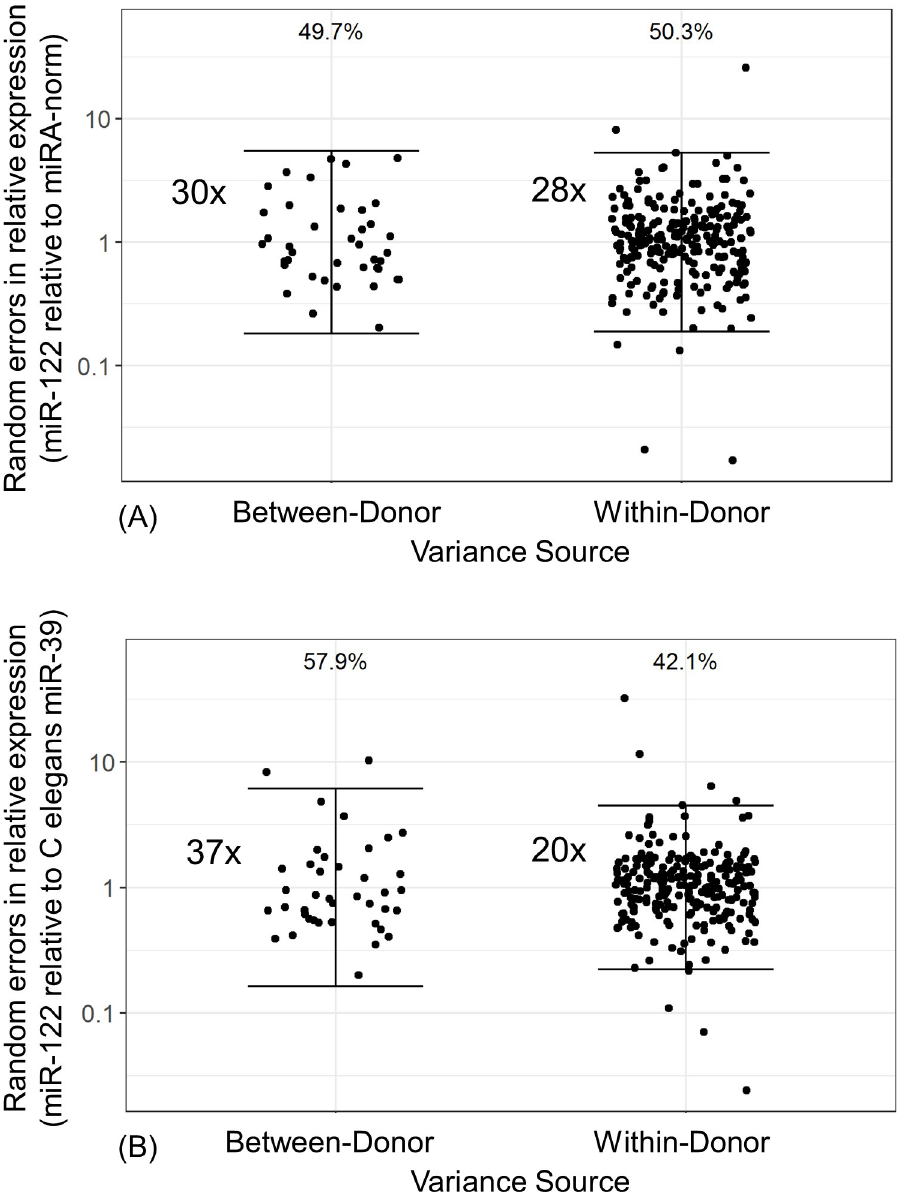
Fig 5. Variance component analysis of miR-122 in serum from healthy volunteers. Variance components of miR- 122 relative expression normalized using MiRA-norm (A) or C . eleg miR-39 (B) in serum from healthy volunteers. Points represent random deviations from between-donor (left) and within-donor (right) means and solid brackets represent reference ranges based on between- (left) and within- (right) donor variation. Proportion of variance relative to the total is displayed above each variance